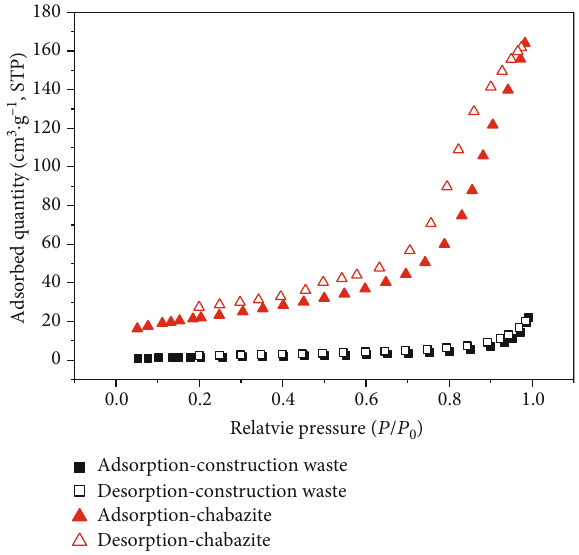
Figure 4: N adsorption/desorption curves of construction waste 2 and chabazite at 77K.